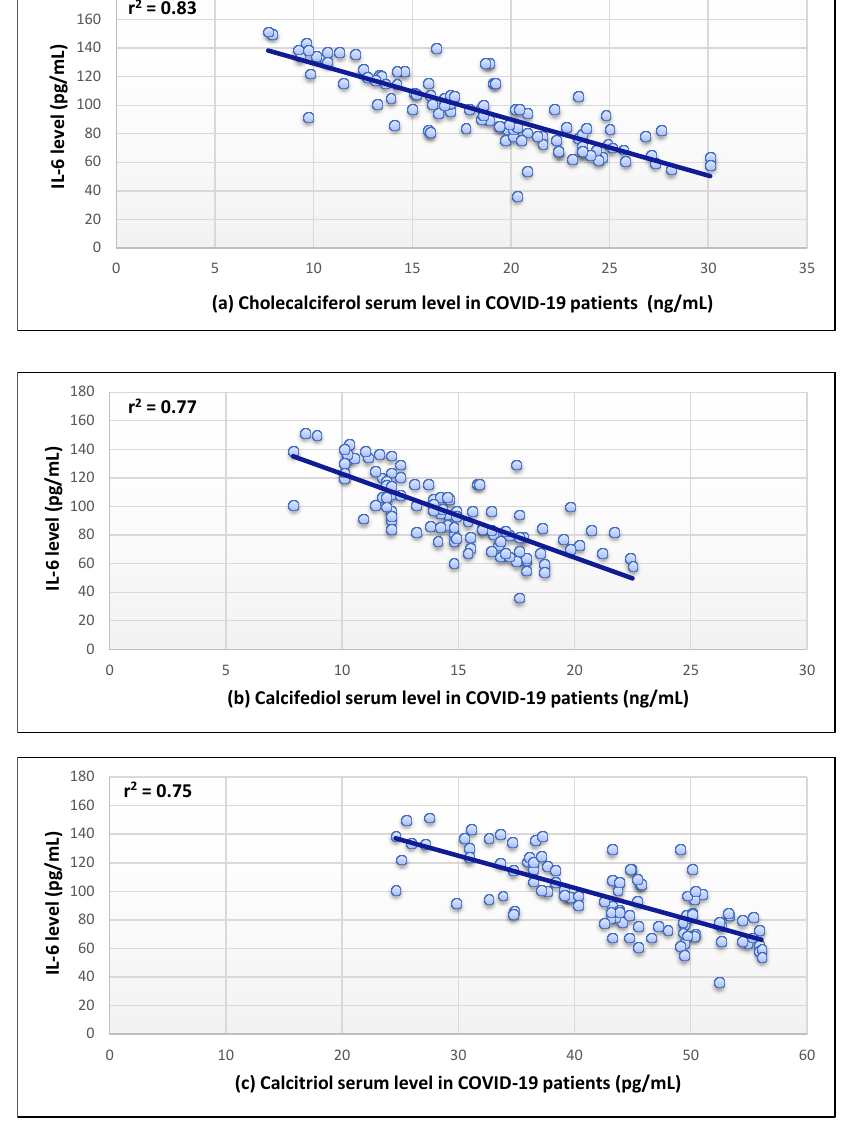
Figure 3. Correlation between the levels of interleukin-6 (IL-6) and ( a – c ) in COVID-19 patients.